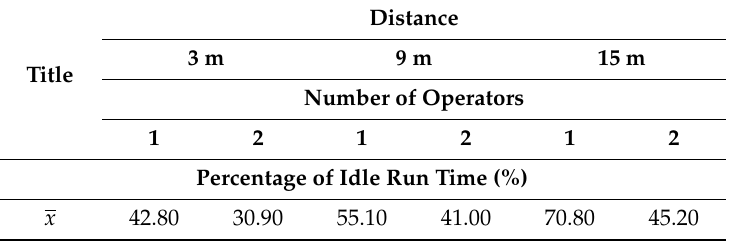
Figure 5. A ratio of the chipper idle run time to the number of operators and the distance of the pile of branches to the chipper; A—for one operator, B—for two operators, C—range of idle run time reduction due to increased number of operators to two. Table 1. Percentage of idle run time during chipping processes and frequency of operating condition